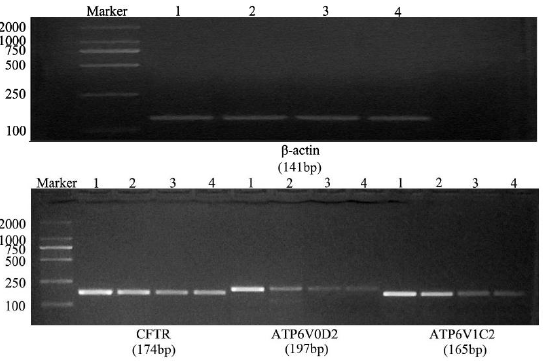
Figure 4. Results of conventional PCR amplification of β -actin, CFTR, ATP6V0D2, and ATP6V1C2 mRNAs. 1. Newborn group; 2. Juvenile group; 3. Adult group; and 4. Elderly group.